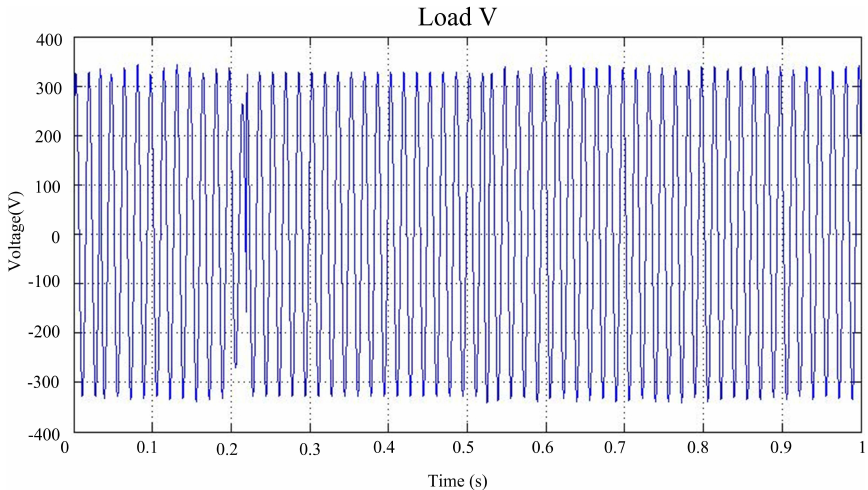
Figure 13. Voltage wave of the load.